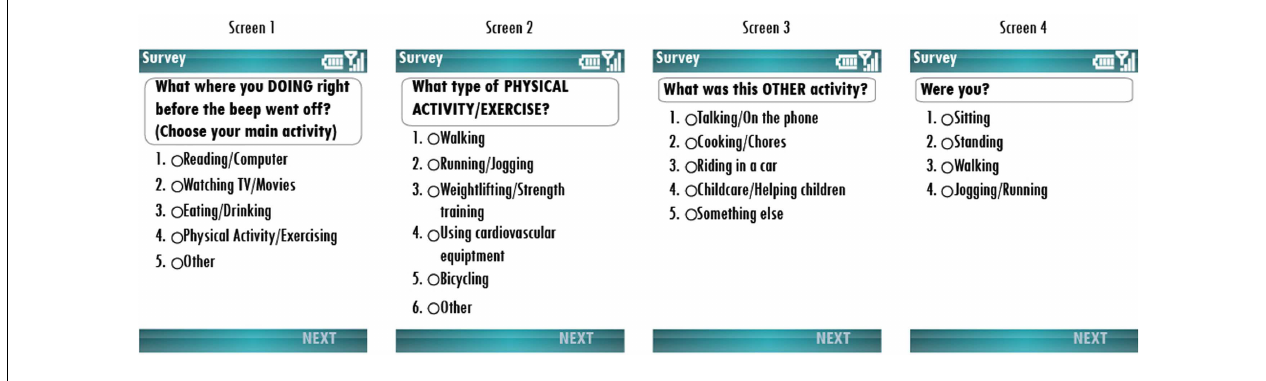
FIGURE 1 | Ecological momentary assessment (EMA) screen shots. Images display how Ecological Momentary Assessment (EMA) items and response choices appeared on the display screen of the mobile phone. Respondents used the key pad to toggle up/down and select their response. Only one response choice could be selected per screen. If a